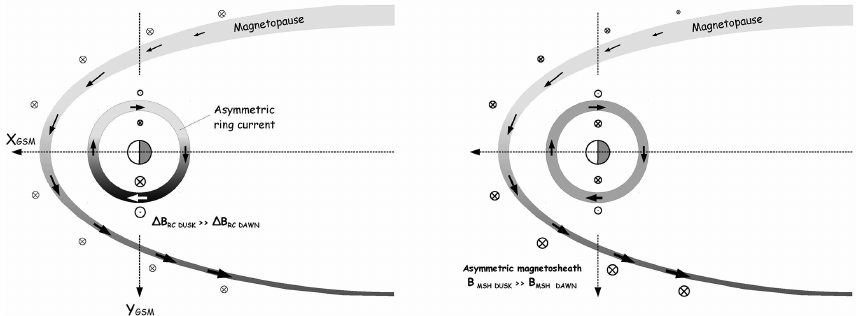
Figure 5. Possible explanations for the asymmetric magnetopause current density: internal, caused by ring current (left), or external, caused by magnetosheath (right) (from Haaland and Gjerloev, 2013).